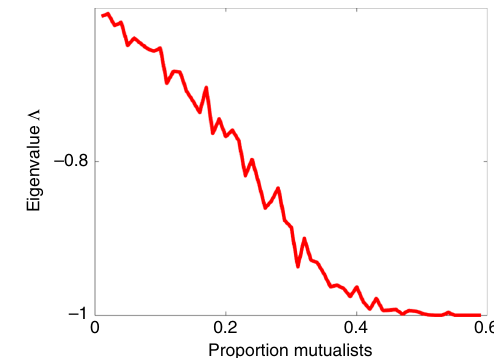
Fig. 2 The critical stability eigenvalue Λ . The eigenvalue Λ is plotted as a function of P , the proportion of mutualistic interaction pairs, as an average of 50 runs. The more negative is Λ , the more stable is the (feasible) system in the sense that it has faster return time to equilibrium 36 and thus higher resilience. Parameters: n = 100 species; interaction variability σ = 0.02; connectance C = 0.7; growth rates r i